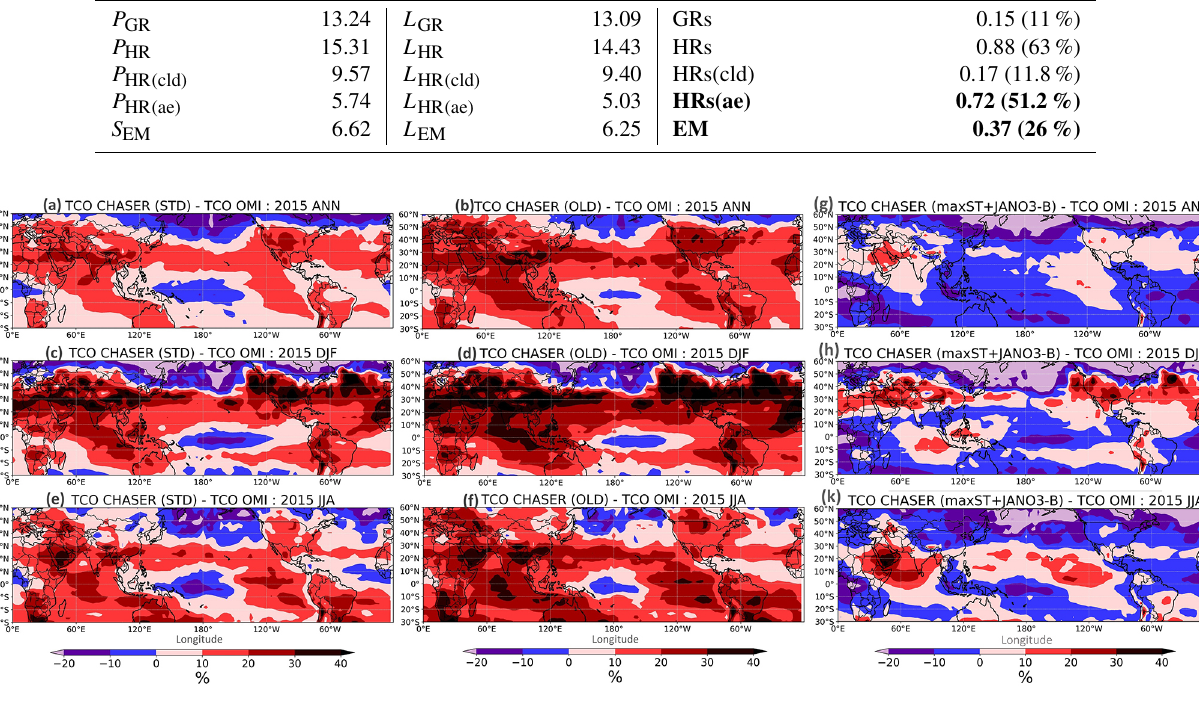
Figure 13. TCO percentage differences between model and OMI. (a, c, e) STD versus OMI and (b, d, f) OLD versus OMI for annual (a, b) , December–January–February (DJF) (c, d) , and June–July–August (JJA) (e, f) . (g, h, k) Differences for the maxST + JANO3-B case versus OMI for annual, DJF, and JJA, respectively (g, h, k)